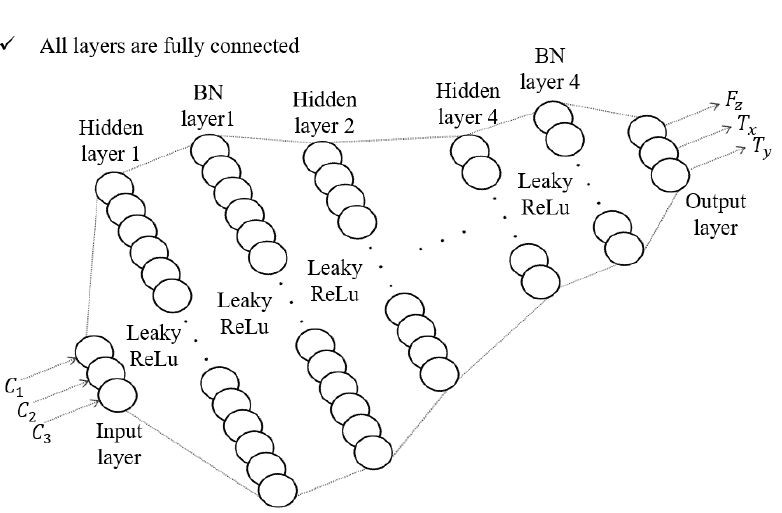
Figure 9. The model of the DNN calibration